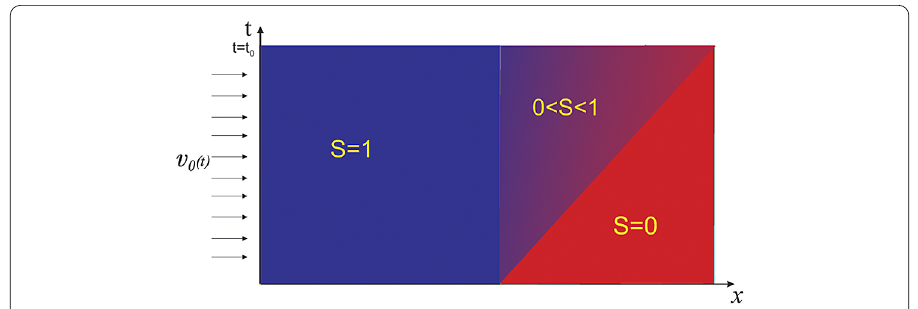
Figure 4 The limit of rigorous numerical upscaling. The domain occupied by the water tongues at a fixed time becomes under homogenization a mushy region, where the concentration s of water varies from 1 to 0.